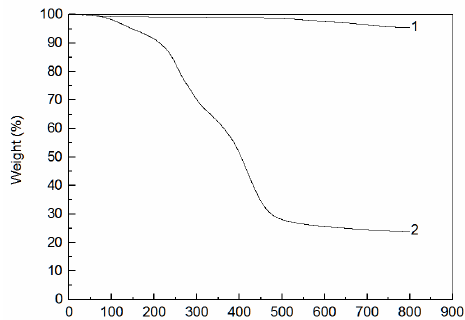
Figure 2. TGA curves of fly ash and amidoxime modified polyacrylonitrile/fly ash composite. (1. Fly Ash; 2. Amidoxime modified polyacrylonitrile/fly ash